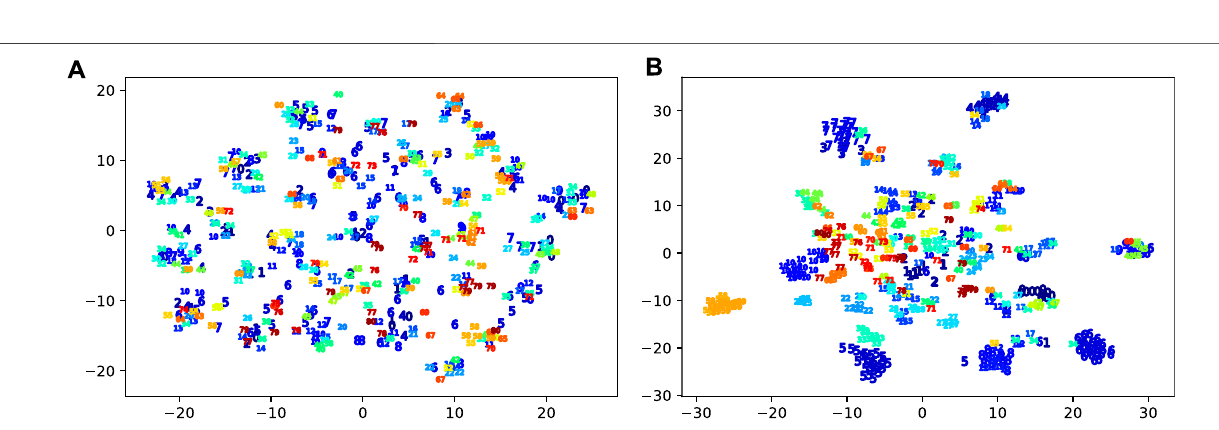
FIGURE 5 | Latent space after compression by t-SNE: (A) result of only MNVAE and (B) result of MNVAE + MLDA. The numbers at the data points represent the correct category index.